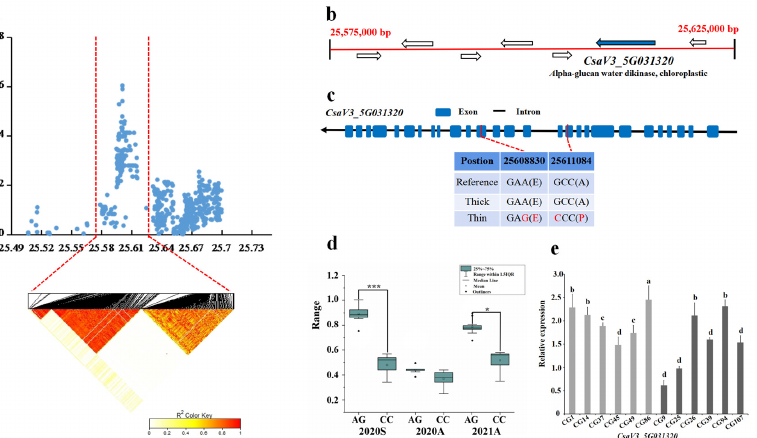
Figure 7. Identification of the stem diameter-related gene at locus gSD5.2 . ( a ) Manhattan map of near 300 kb ( top ) and LD heatmap ( bottom ) surrounding the peak of gSD5.2 . ( b ) Seven genes predicted in the LD block region. Blue represents the genes that are different. ( c ) SNP variation of the candidate gene CsaV3_5G031320 among thick and thin stem lines (Table S6). Two SNP (in red) were located in CDS, resulting in amino acid changes. ( d ) Haplotype difference of CsaV3_5G031320 . *** indicatess significance p < 0.001. ** indicatess significance p < 0.01. * indicatess significance p < 0.05. ( e ) Relative expression analysis of CsaV3_5G031320 . Gray column represents the thin stem samples (CG1, CG14, CG37, CG45, CG49, CG86); Black column represents thick stem samples (CG9, CG25, CG26, CG39, CG94, CG107). a,b,c and d represent the level of significant difference from high to low.